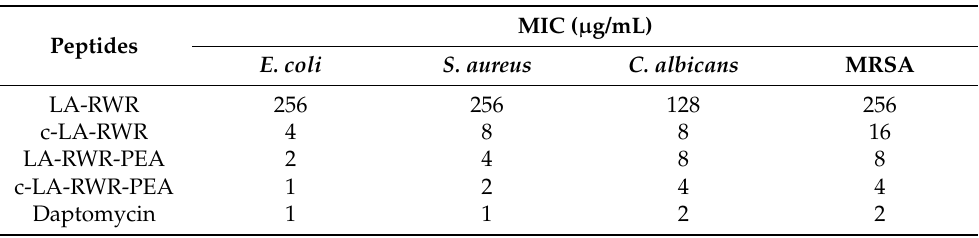
Table 1. The MICs of LA-RWR, c-LA-RWR nanoparticles, LA-RWR-PEA, c-LA-RWR-PEA nanoparti- cles, and daptomycin as control.